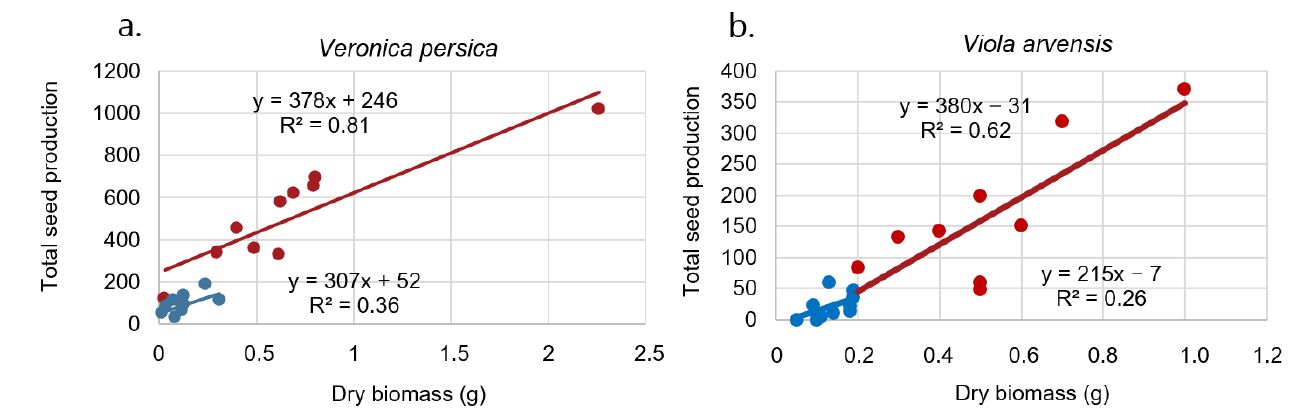
Figure 4. Relationship between plant dry biomass and seed number per plant for ( a ) V eronica persica and ( b ) Viola arvensis. The red points correspond to observations in 2018, and the blue points correspond to observations in 2017. Regression lines are shown for both years.